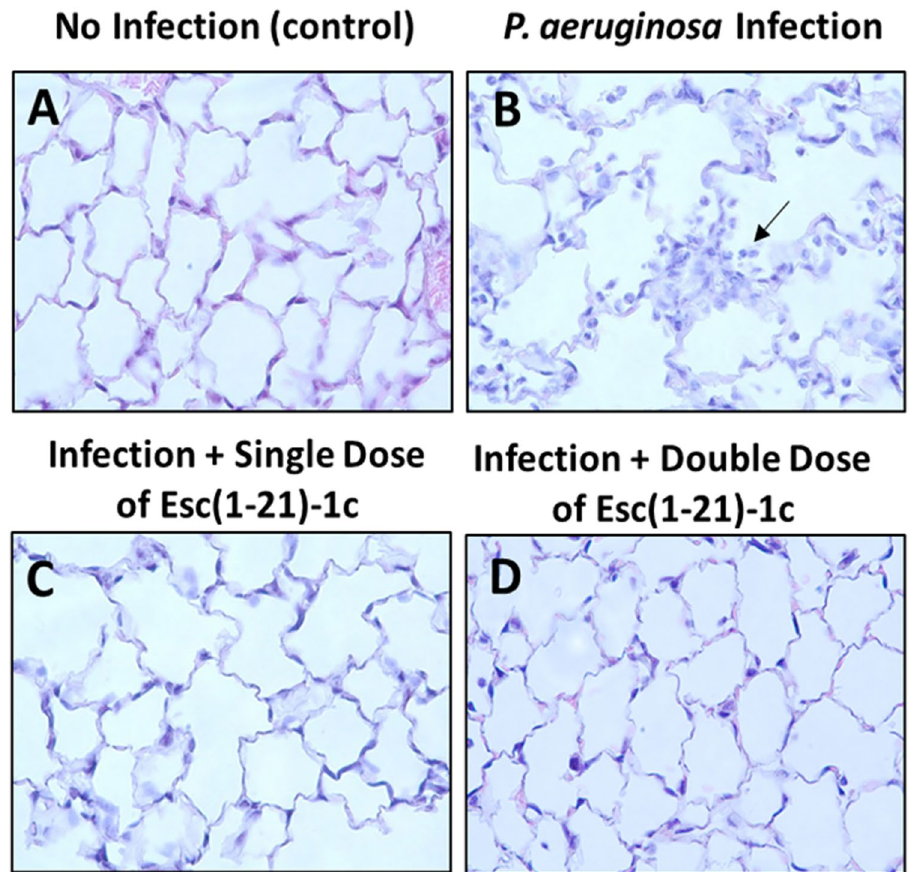
Figure 7. Histologic analysis of lung tissues with PAO1 challenge at 24 hours after bacterial infection. Mouse lung tissues were harvested, fixed and stained for histological evaluation without peptide treatment ( B ) or with a single ( C ) and double ( D ) administration of Esc(1–21)-1c at 0.1 mg/kg in comparison with non-infected and untreated samples. ( A ) Infected but untreated mice ( B ) exhibited more inflammation, airway lumen leukocyte accumulation (black